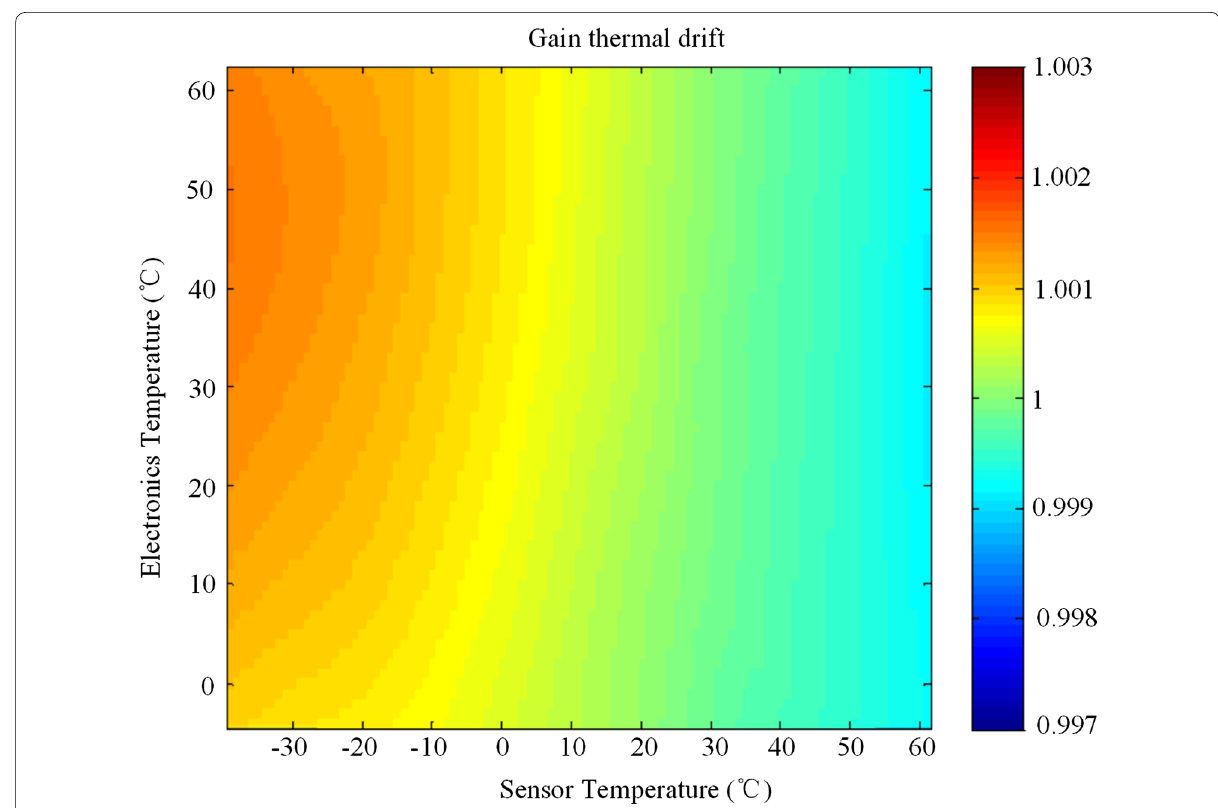
Fig. 9 Gain factor thermal drift as a function of sensor temperature and electronics